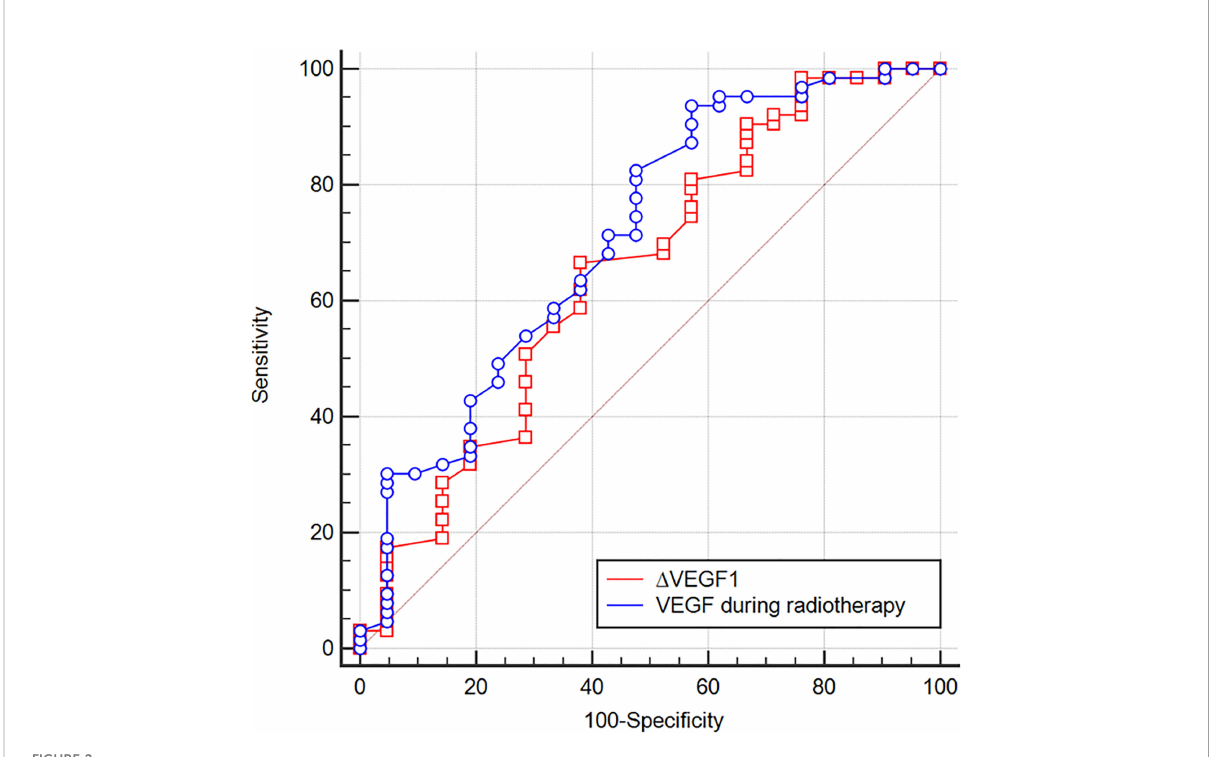
FIGURE 2 ROC curves of using VEGF during radiotherapy and Δ VEGF1 to predict the treatment ef fi cacy of ESCC. When VEGF = 115 pg/ml during radiotherapy was used as the cut-off value to predict the short-term ef fi cacy, the AUC was 0.710, the sensitivity was 93.7%, the speci fi city was 42.9%, z=2.997, P=0.003; when Δ VEGF1 = -4% was used as the cut-off value to predict the short-term ef fi cacy, the AUC was 0.651, the sensitivity was 66.7%, the speci fi city was 61.9%, z=2.042, P=0.041.